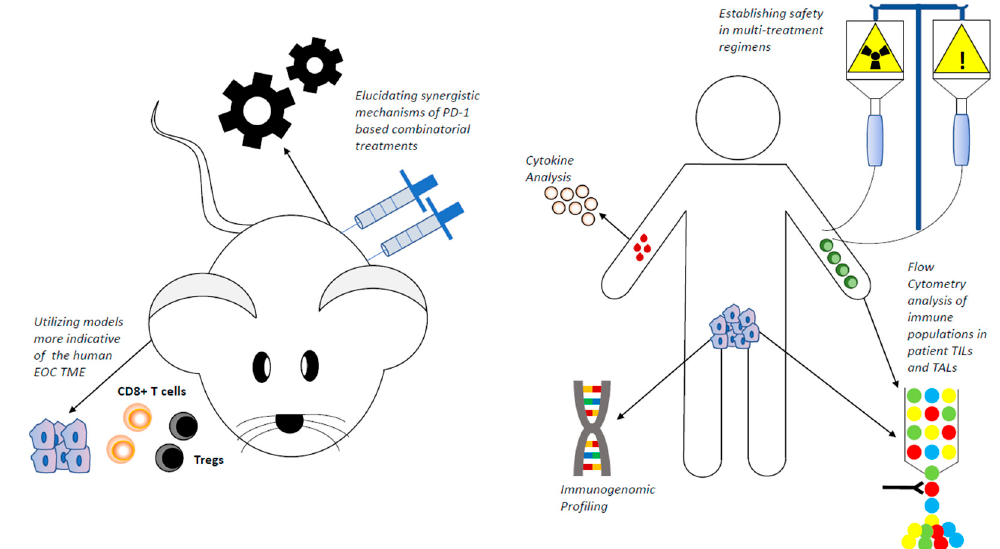
Figure 1. Preclinical and clinical areas of focus to enhance PD-1-based combinatorial treatment response.